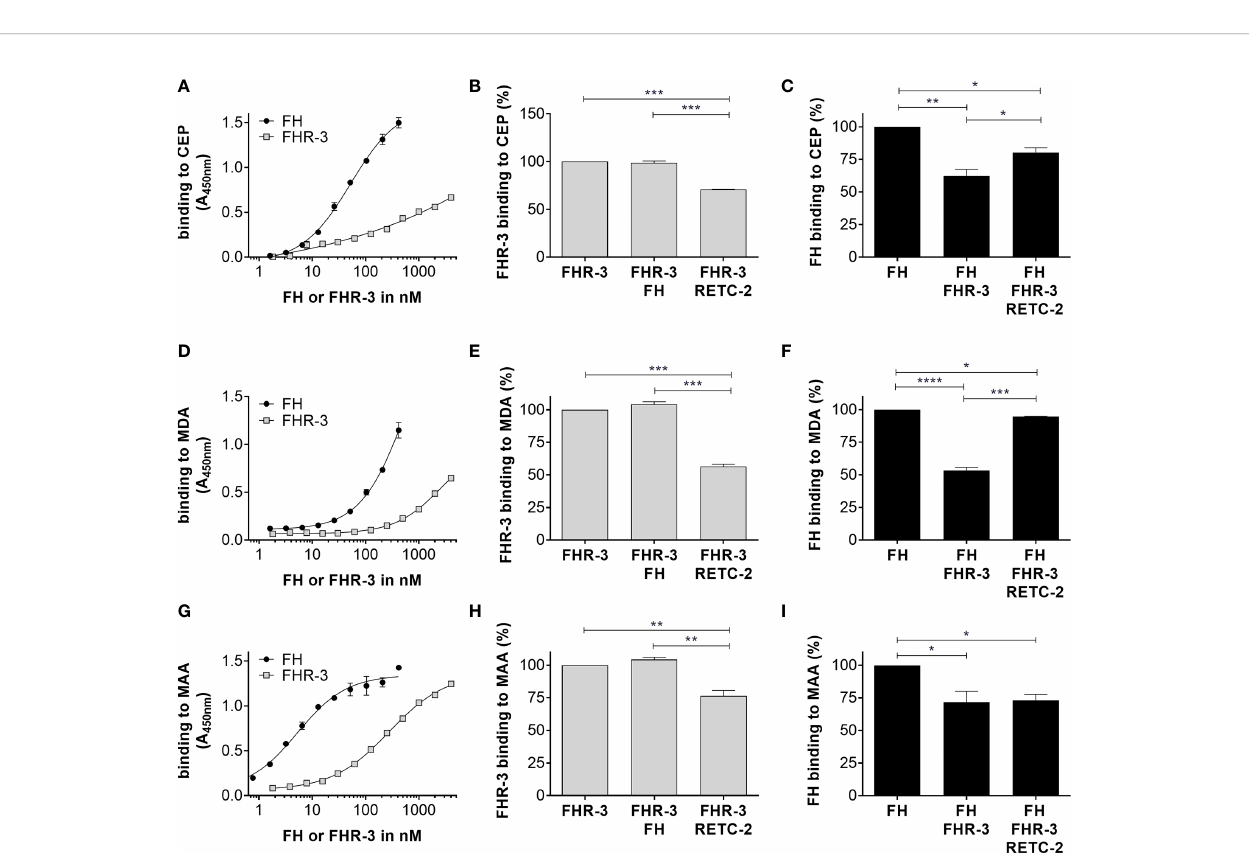
FIGURE 2 | FHR-3 and FH interacted with OSEs and RETC-2 reduced this competitive binding. All three lipid peroxidation products (A) CEP, (D) MDA, and (G) MAA interacted concentration dependently with FHR-3 and FH. FH (black) showed a higher binding strength than FHR-3 (grey) to the OSE. Interaction of FHR-3 with (B) CEP, (E) MDA, or (H) MAA could not be reduced by additional incubation with FH, but RETC-2 signi fi cantly reduced the binding of FHR-3 to all three peroxidation products. Interaction of FH to (C) CEP, (F) MDA, and (I) MAA was signi fi cantly reduced by additional incubation with FHR-3, and anti-FHR-3 antibody RETC-2 was able to reverse this inhibitory effect completely ( F , MDA), partially ( C , CEP), or not at all ( I , MAA). ****p < 0.0001, ***p < 0.001, **p < 0.01, *p < 0.05 (one-way ANOVA with Dunnett ’ s multiple comparisons test, n =